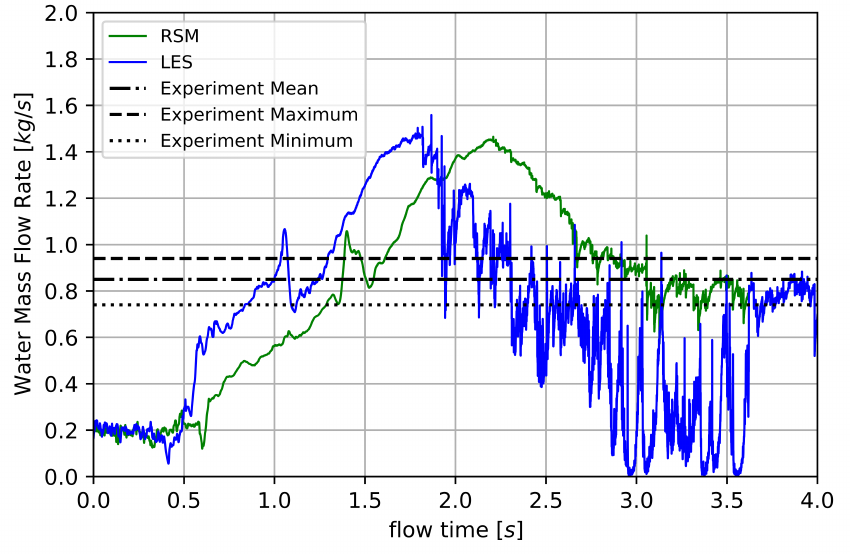
Figure 6. Underflow water mass flow rate as predicted by VOF-DEM models in relation to